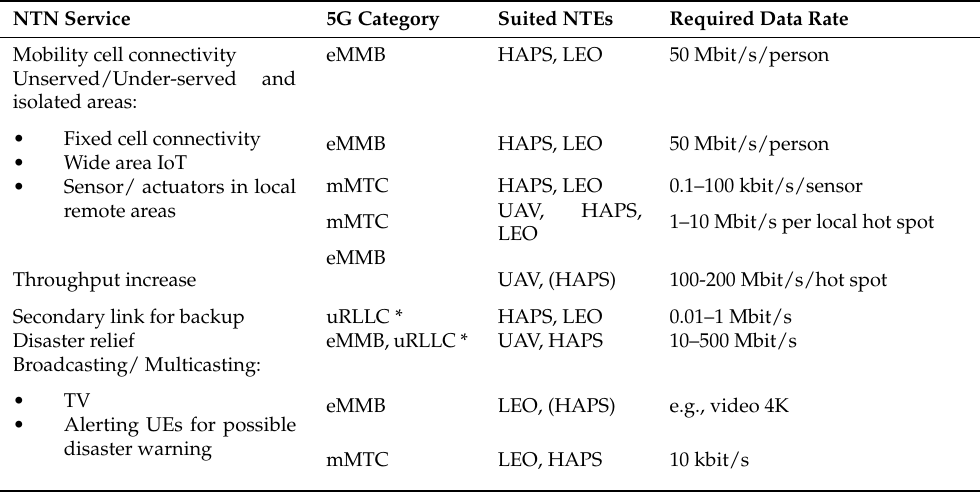
Table 3. Service requirements for NTN